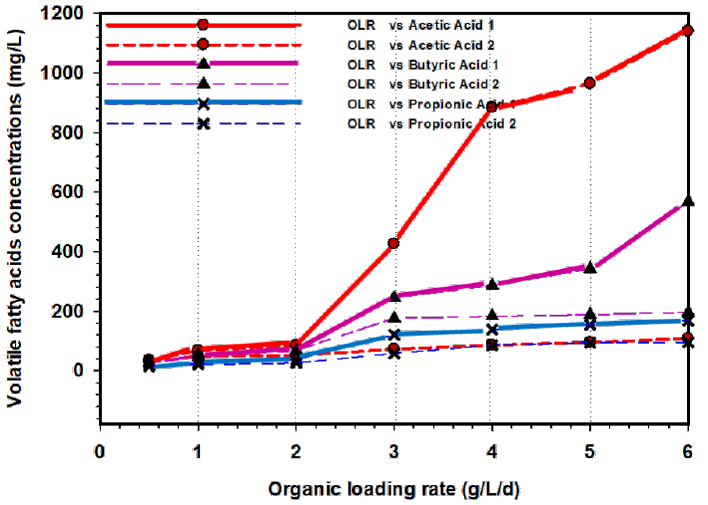
Figure 12. Comparison of VFA formation profiles in UASB 1 and 2.